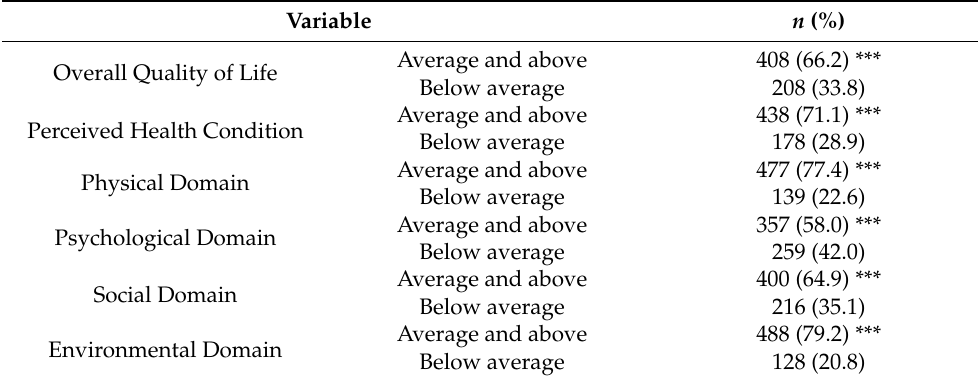
Table 2. Quality of life and perceived health condition in private entrepreneurs from Wrocław ( N = 616). Variable n (%) Average and above 408 (66.2) Overall Quality of Life